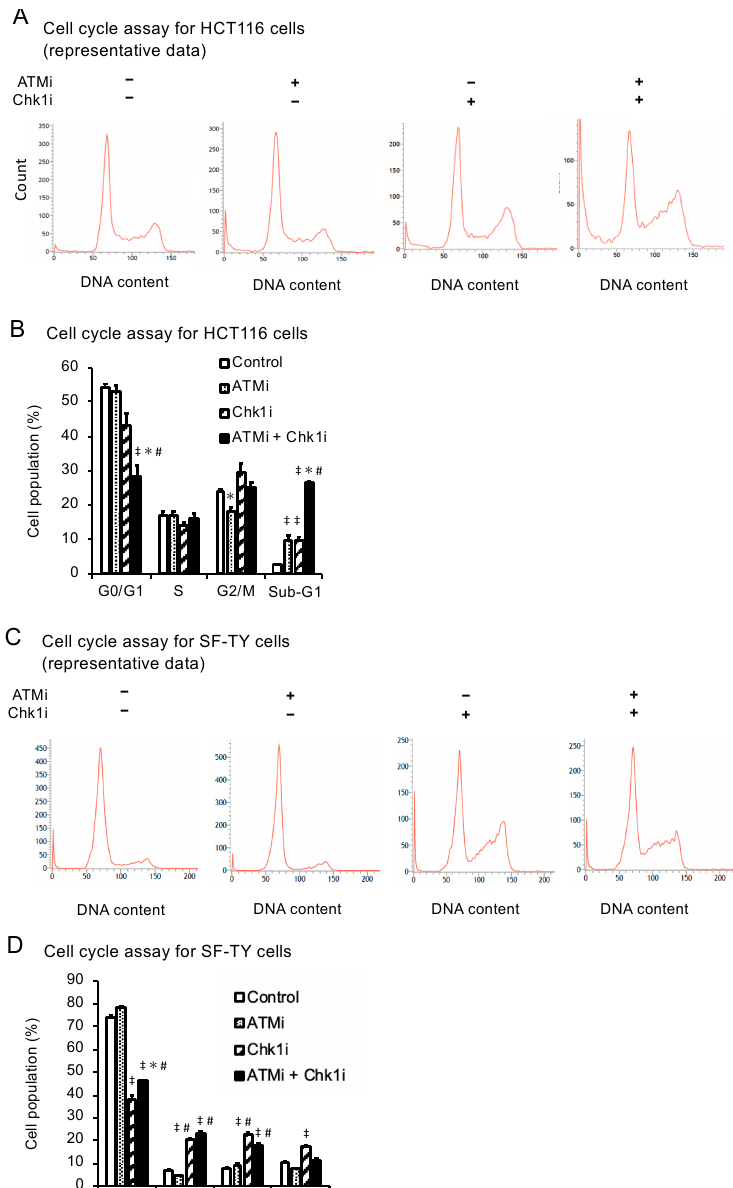
Figure 3. Analysis of the cell cycle progression of cancer and normal cells under the combined ATMi and Chk1i treatment. ( A ) Representative results of the cell cycle progression of HCT116 cells treated with ATMi (10 μ M), Chk1i (0.03 μ M), or both drugs for 48 h, as determined by flow cytometry using PI staining. ( B ) Percentage of HCT116 cells in each cell cycle phase, as determined by PI staining. Data are presented as mean ± SE ( n = 3; ‡ p < 0.05, vs. control; * p < 0.05, vs. ATMi group, # p < 0.05, vs. Chk1i group; Tukey’s multiple comparison test). ( C ) Representative results of the cell cycle progression of SF-TY cells treated with ATMi (10 µ M), Chk1i (0.03 µ M), or both drugs for 48 h, as determined by flow cytometry using PI staining. ( D ) Percentage of SF-TY cells in each cell cycle phase, as determined by PI staining. Data are presented as mean ± SE ( n = 3; ‡ p < 0.05, vs. control; * p < 0.05, vs. ATMi group, # p < 0.05, vs. Chk1i group; Tukey’s multiple comparison